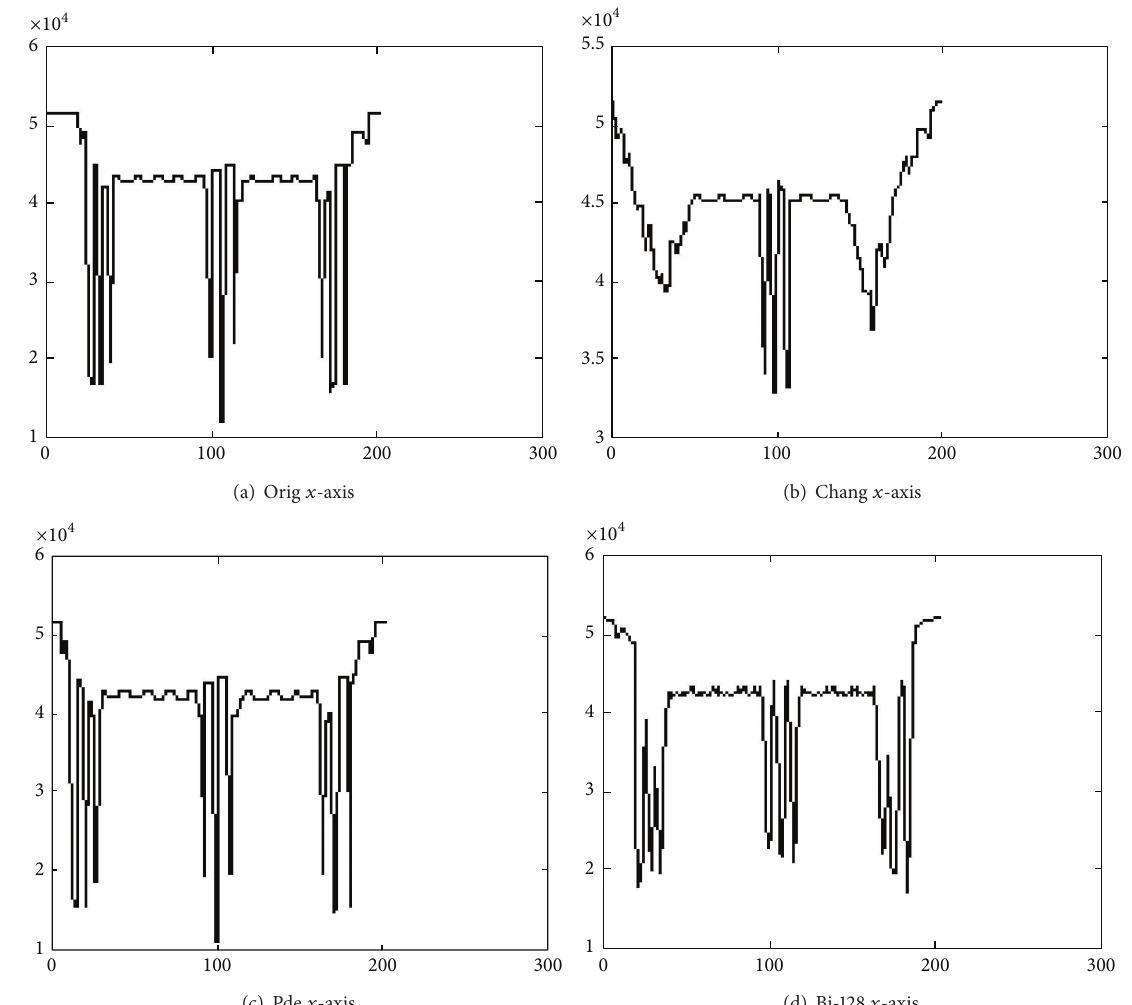
Figure 12: Comparison in Experiment 2: projection of images to the 𝑥 -axis: (a) original image, (b) distorted image, (c) restored image by IEWC, and (d) restored image by the piecewise bilinear